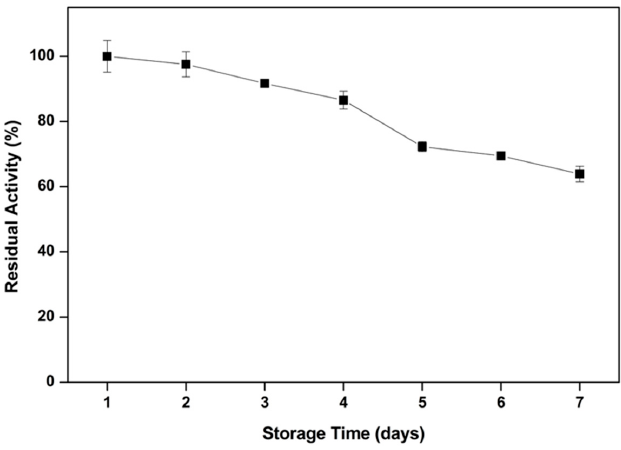
Figure 8. Storage stability of immobilized PLD a2 . The immobilized PLD a2 was stored at 4 ◦ C for several days.